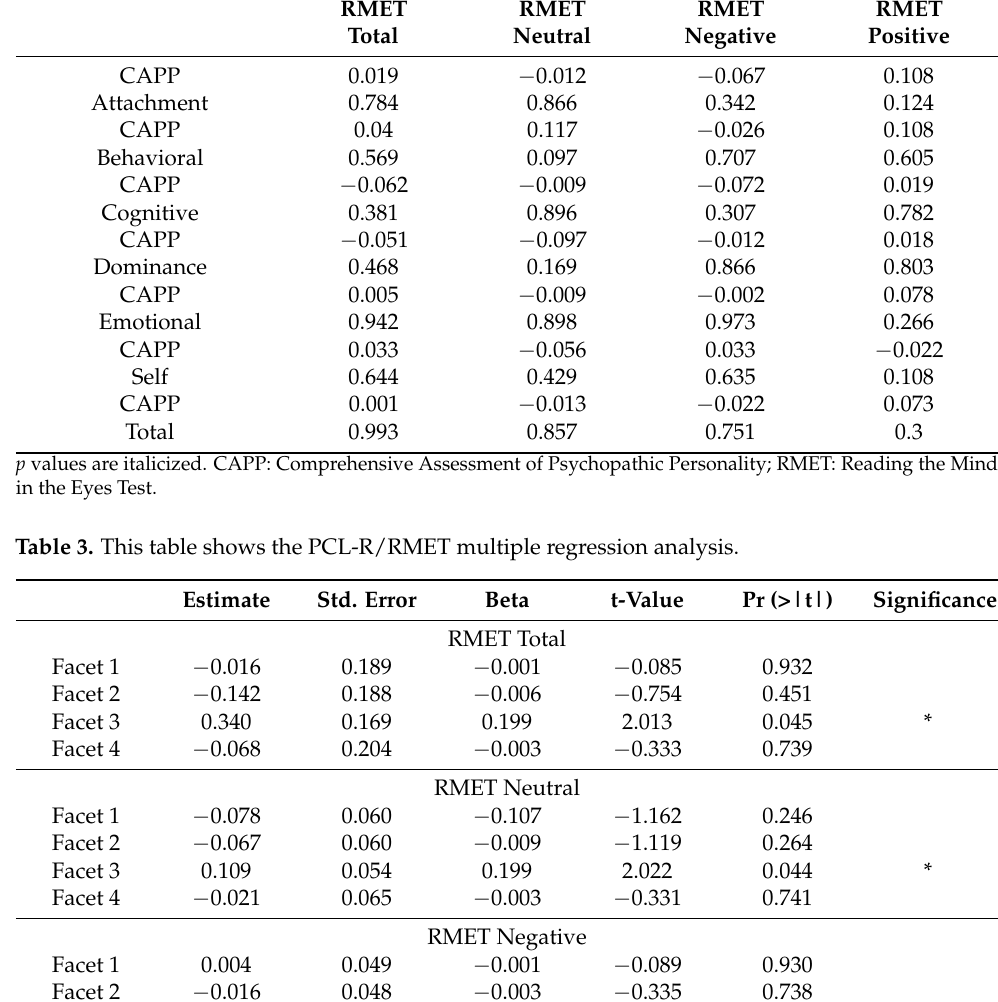
Table 2. This table shows correlations between CAPP (Total, Attachment, Behavioral, Cognitive, Dominance, Emotional and Self scores) and RMET (Total, Neutral, Negative and Positive scores). RMET Total